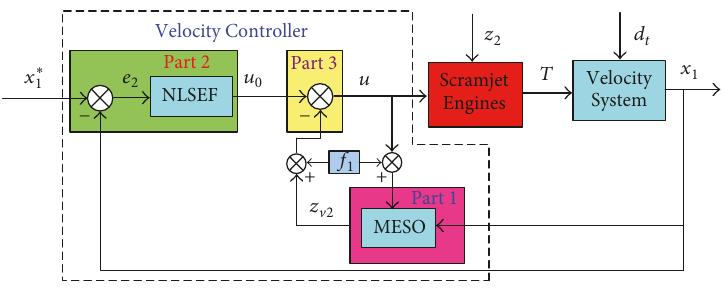
Figure 3: The structure of the ADRC.